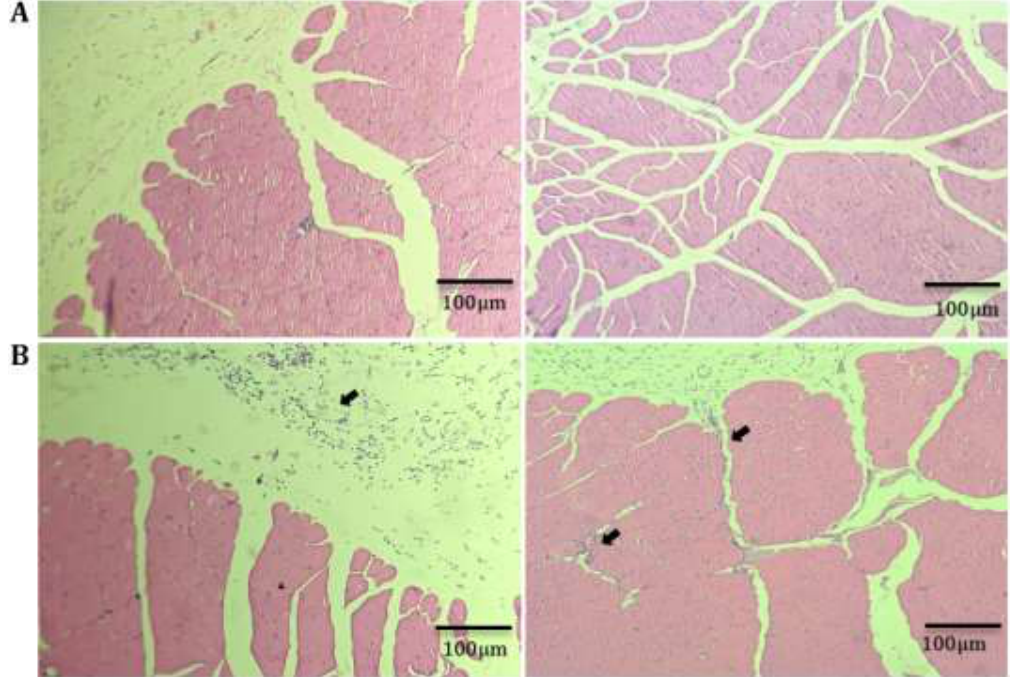
Figure 2. Histological section of normal muscle (A) and infected muscle (B) after 48 h of Candida albicans injections. H & E staining displayed the presence of inflammatory cells in fatty tissue around the muscles and infiltrated to muscle area (black arrows) while normal muscles showed no infiltration of inflammatory